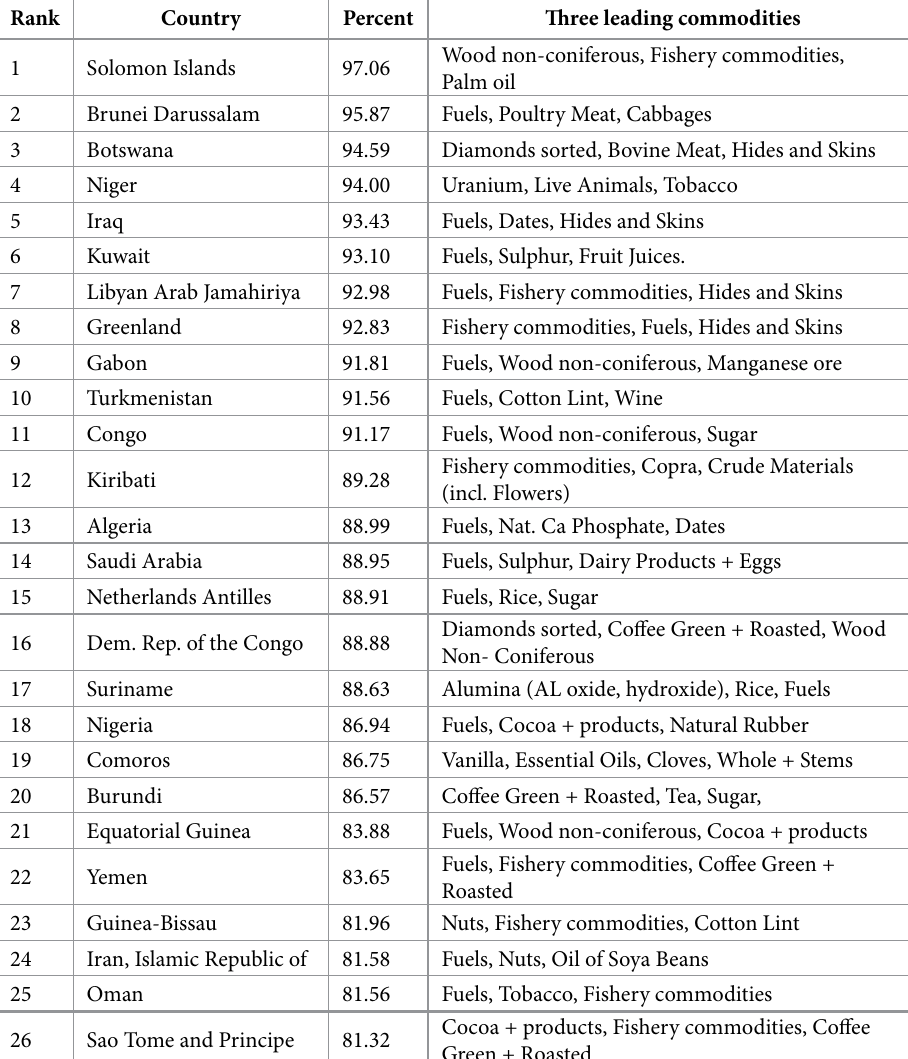
Table 1. Leading commodities in commodity dependent developing countries (ETC Group